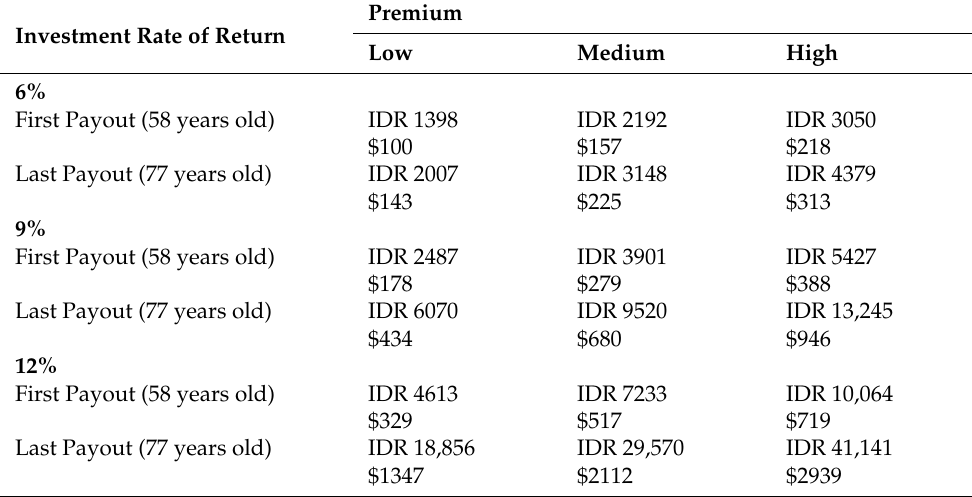
Table 4. Present value of monthly retirement payout Head of Section, III/d (in thousand IDR). Investment Rate of Return